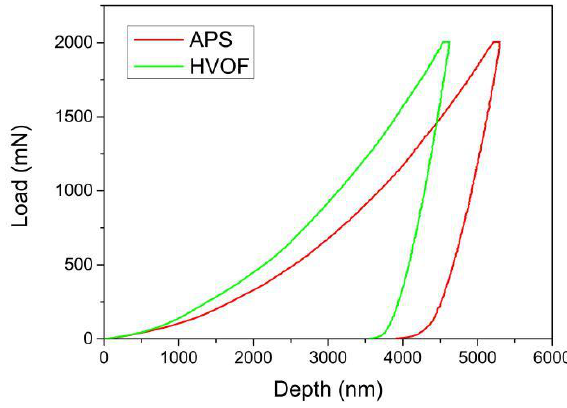
Figure 7. Load-depth curves of the HEA coatings. Table 5. Mechanical properties of the HEA coatings.